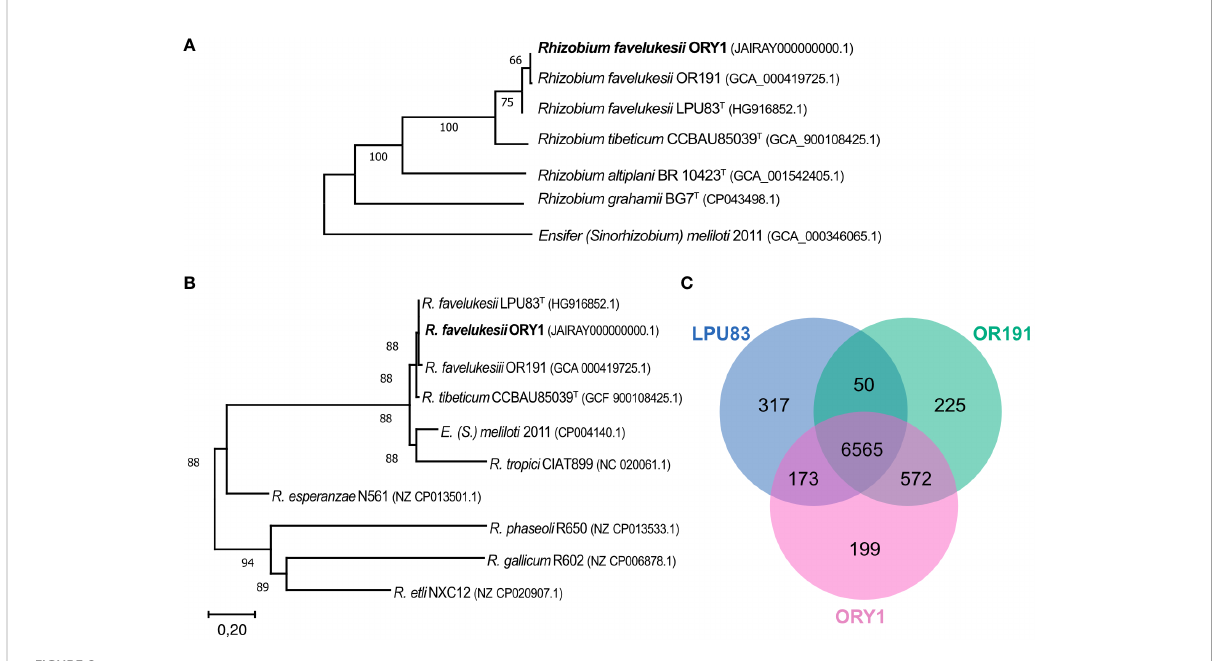
FIGURE 2 Phylogenetic analysis and Venn diagram of homologous genes in three R. favelukesii strains. (A) Tree inferred from Genome Blast Distance Phylogeny (GBDP) distances calculated from genome sequences with TYGS (https://tygs.dsmz.de/). The branch lengths are scaled in terms of GBDP distance. The numbers above branches are GBDP pseudo-bootstrap support values > 60% from 100 replications, with an average branch support of 83.8%. The tree was rooted at the midpoint. (B) MLSA of symbiotic genes nifD, nifK, nifH, nodA, nodB, and nodD of different rhizobia species. (C) Venn diagram of homologous genes in three R. favelukesii strains. Overlapped regions represent common homologous genes shared between